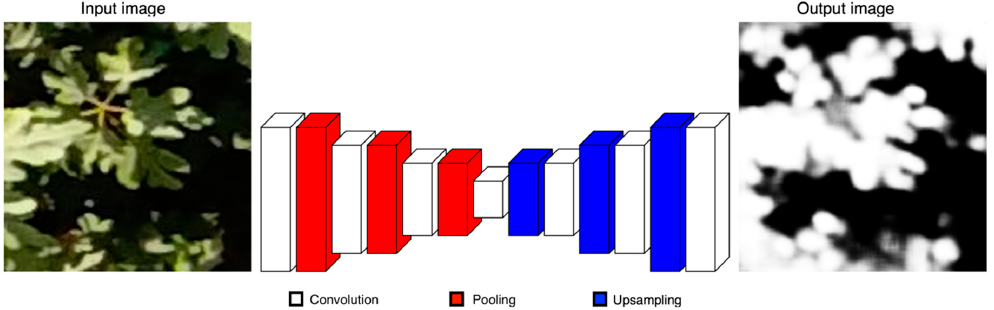
Figure 3. A scheme of the proposed architecture.